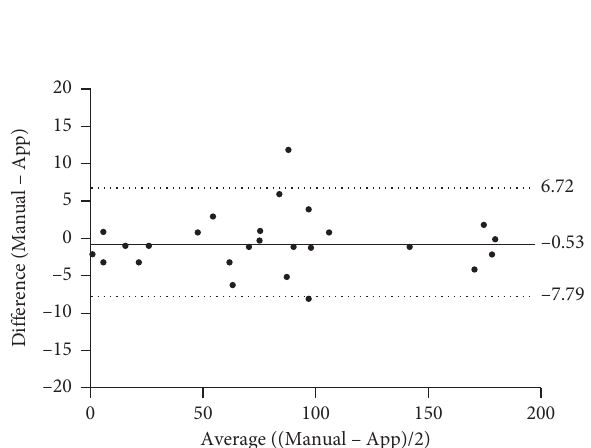
Figure 4: Evaluation of the agreement between the measurements of the IOL angle made by the application and those made by the manual method in 30 eyes with a Bland–Altman